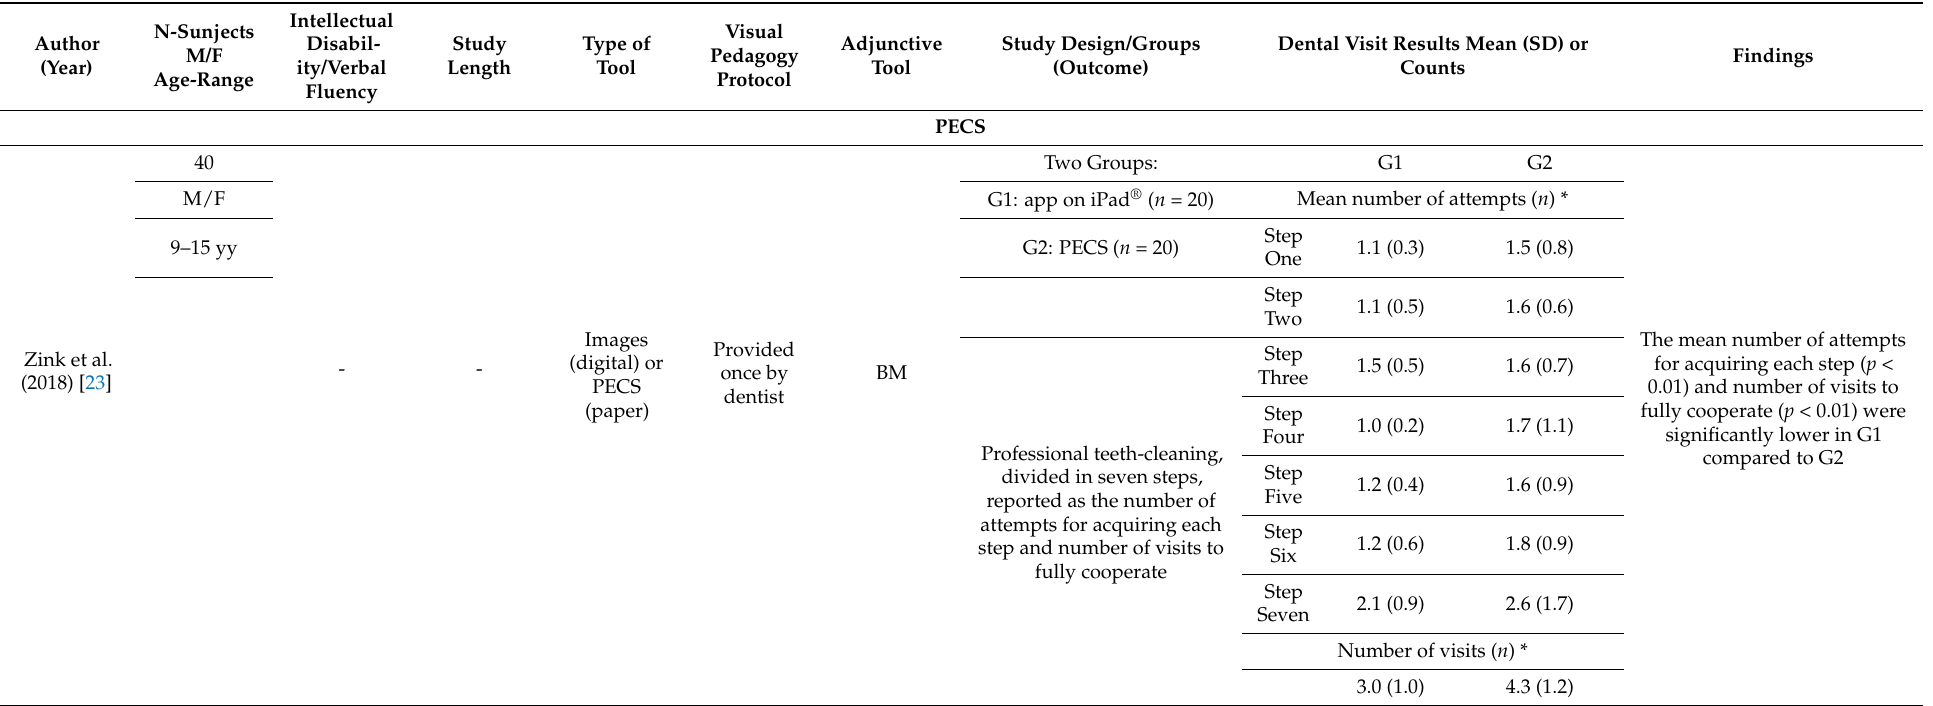
Table 3. Main characteristics of the included studies regarding ASD children’s behavior during dental care